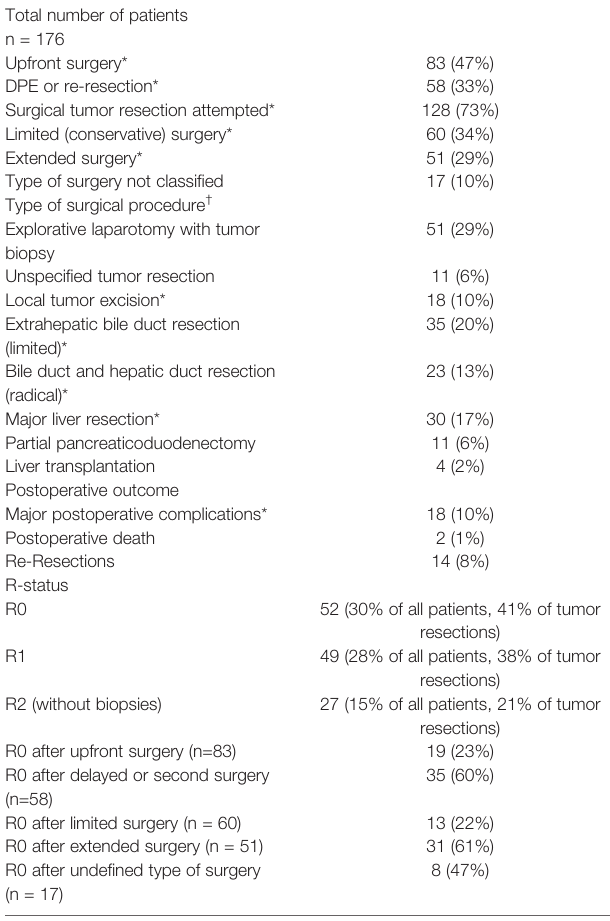
TABLE 2 | Details of surgical therapy.